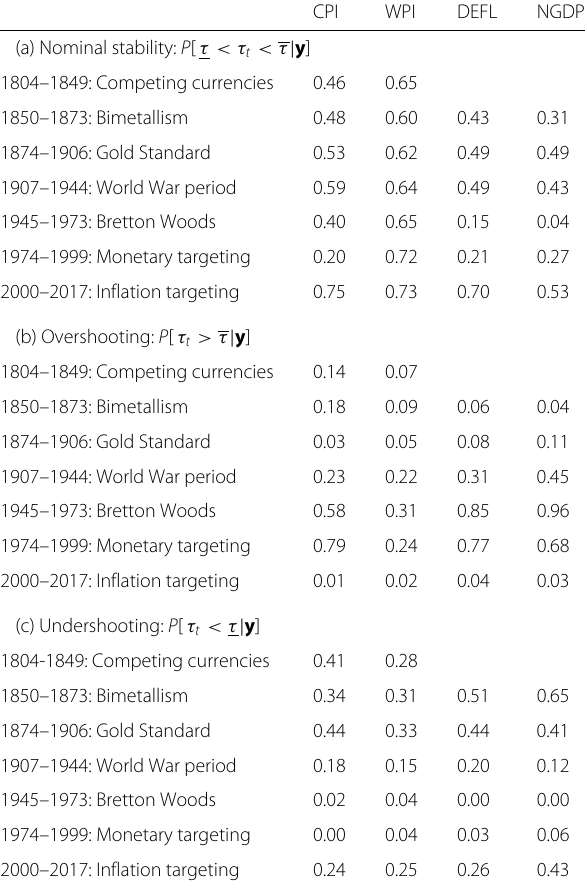
Table 4 Probability of nominal stability (with alternative prior)